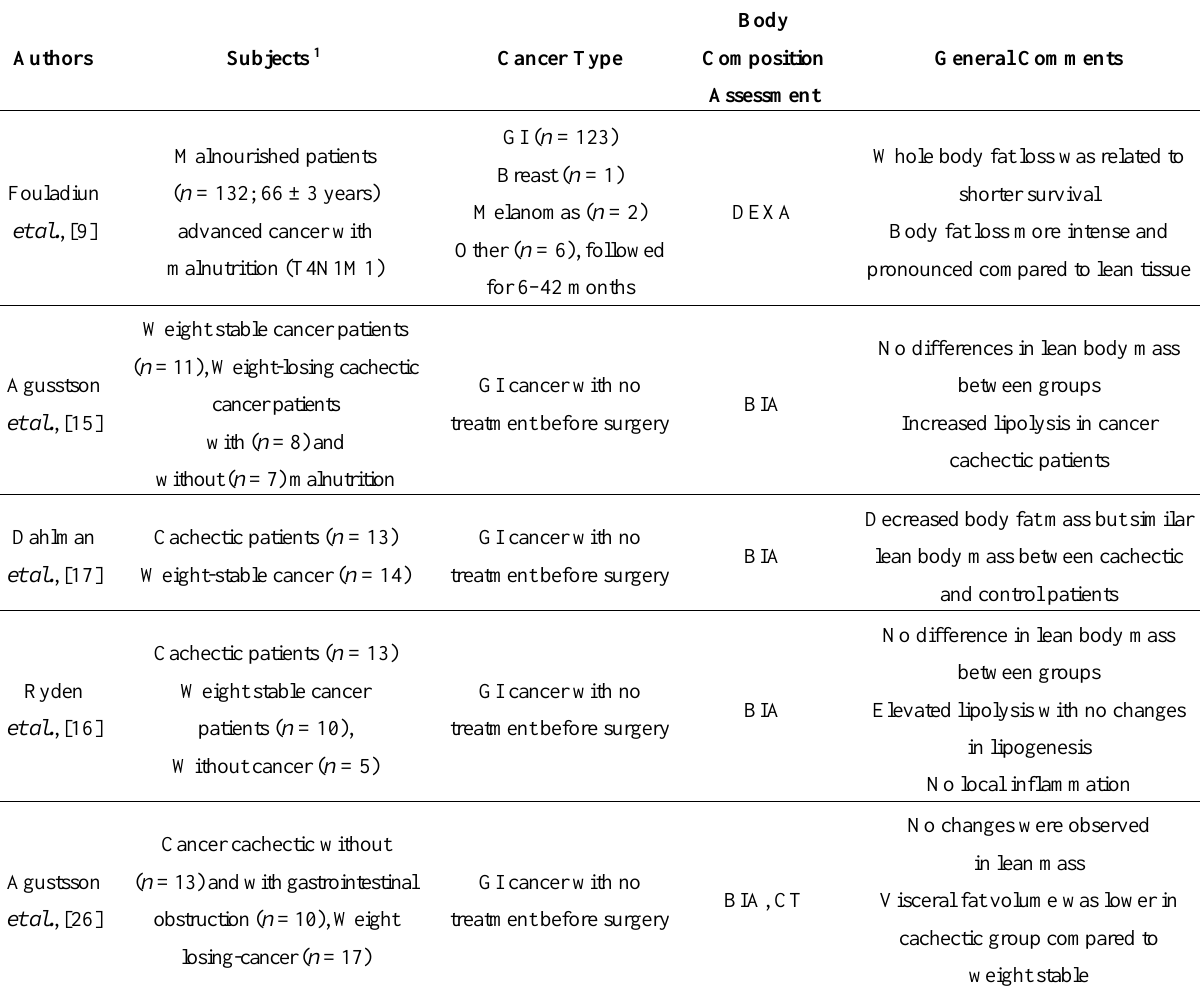
Table 1. Articles reporting fat and lean tissue loss in newly diagnosed cancer